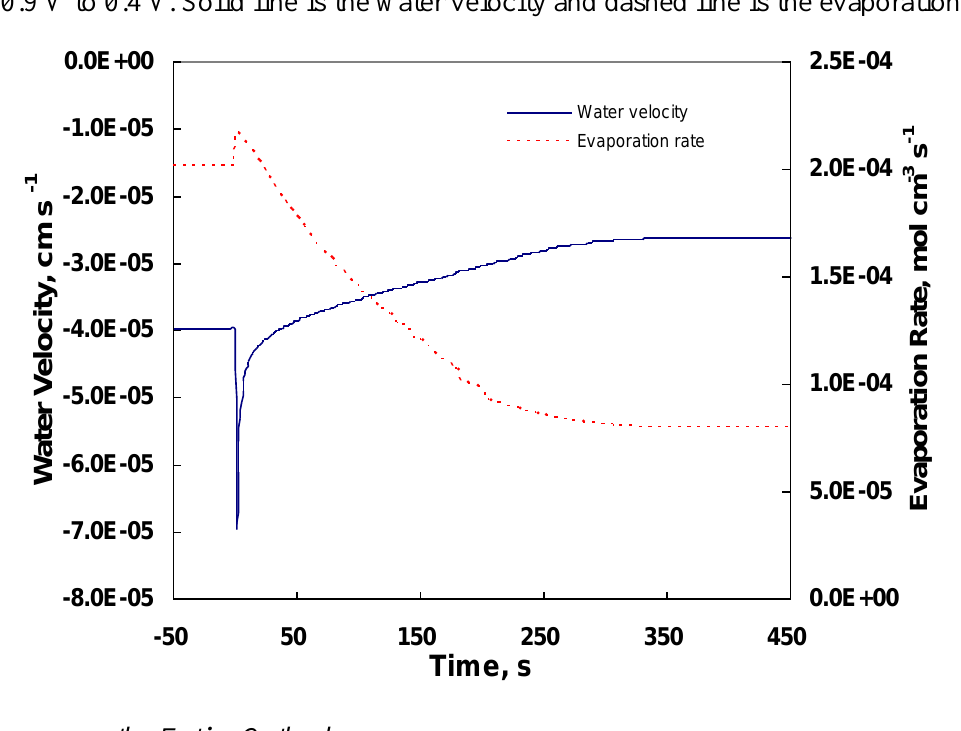
Figure 6. Response of water velocity and evaporation rate to a step potential change from 0.9 V to 0.4 V. Solid line is the water velocity and dashed line is the evaporation